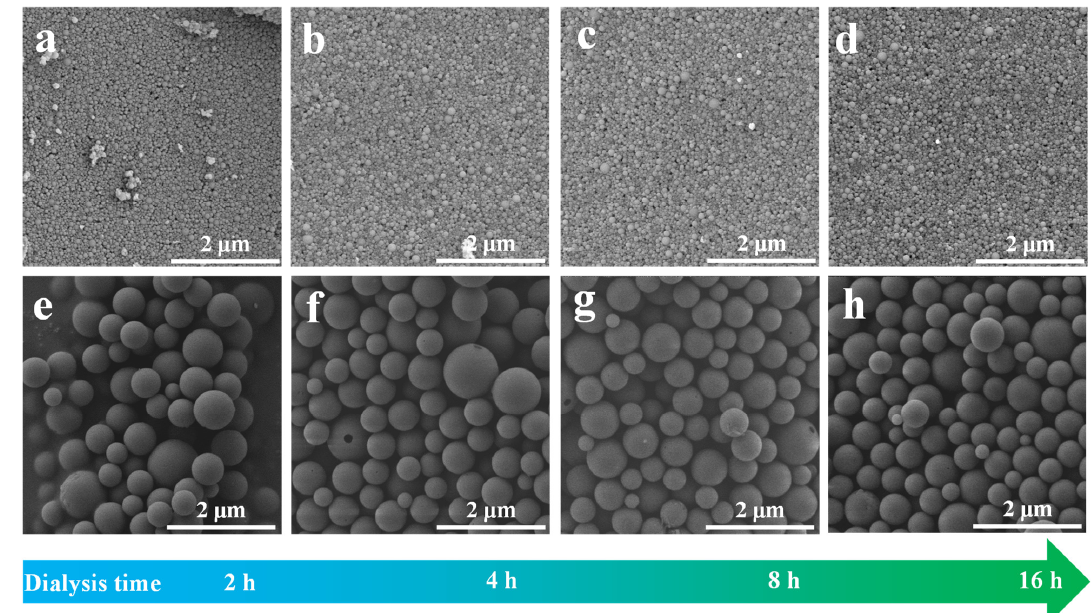
Figure 2. SEM images of ( a – d ) TLNPs-X and ( e – h ) CLMPs-Y, the first row of the image represents TLNP samples, and the second row represents CLMP samples, where X and Y represent dialysis time. ( a – d ) correspond to 2, 4, 8, 16 h respectively; ( e – h ) correspond to 2, 4, 8, 16 h respectively.